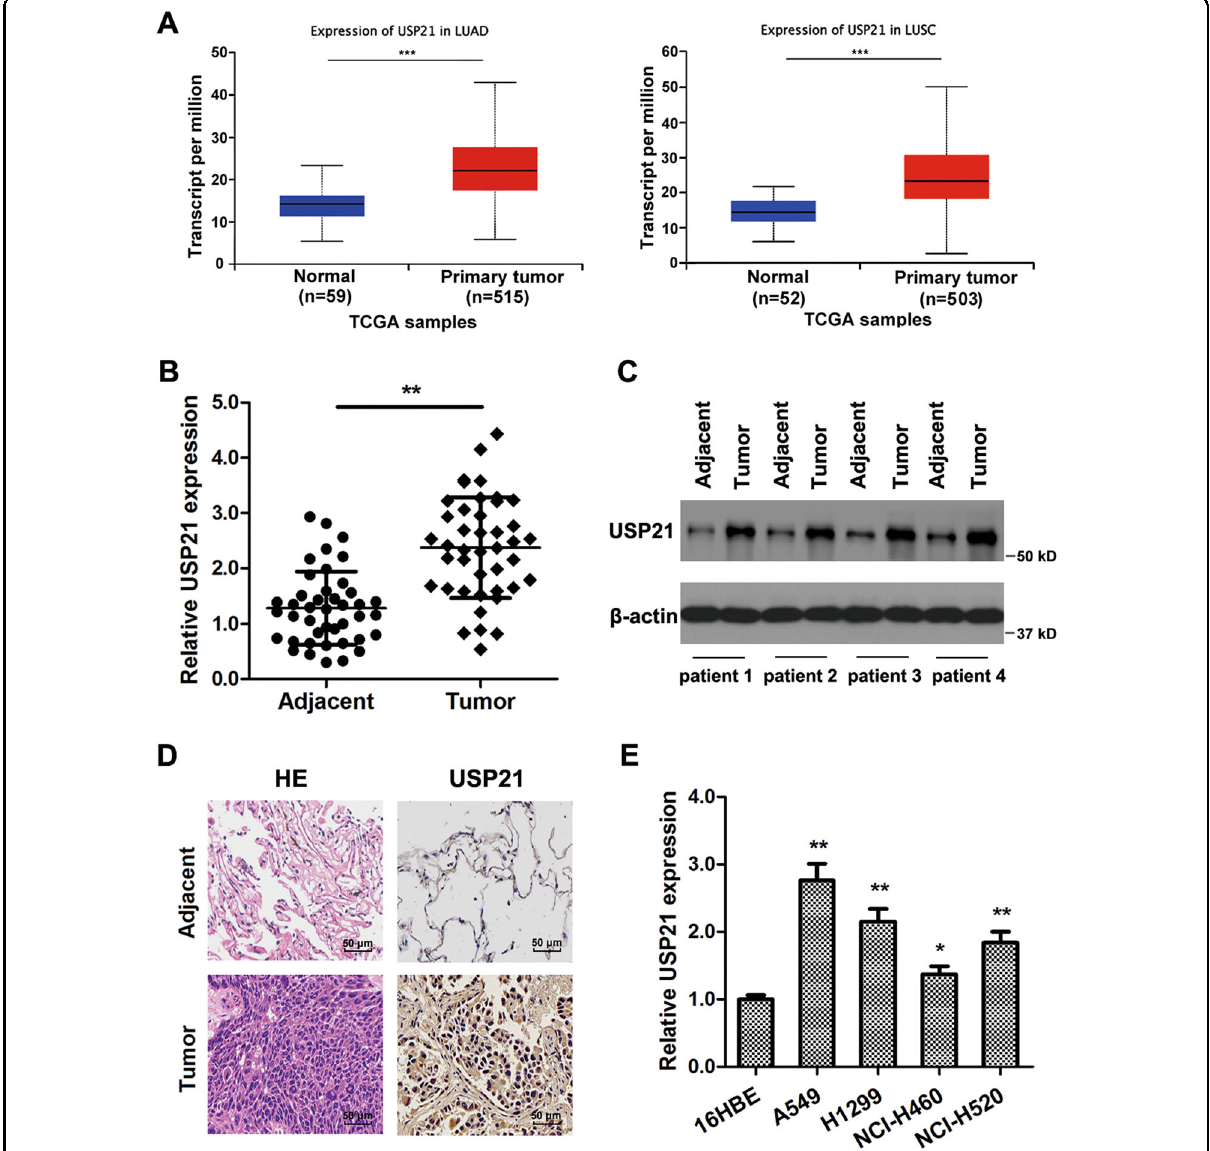
Fig. 1 USP21 is overexpressed in non-small-cell lung cancer (NSCLC) tissues and cells. a Transcript levels of USP21 in lung cancer patients and normal tissues using the LUAD and LUSC data set of The Cancer Genome Atlas. b The relative USP21 expression levels of 42 paired lung cancer tissue samples compared to adjacent normal tissues. c Western blot analyses of the samples for USP21 with adjacent normal tissue samples as the controls. β -Actin was used as an internal control. d Immunohistochemical staining of tissue samples for USP21 with adjacent normal tissue samples as the controls. Scale bar = 50 μ m. e The relative expression levels of USP21 in multiple NSCLC cell lines, A549, H1299, NCI-H520, and NCI-H460 and normal control 16HBE cells. The means ± SD ( n = 3) are shown in b , e . * p < 0.05, ** p < 0.01, *** p < 0.001 vs. the corresponding